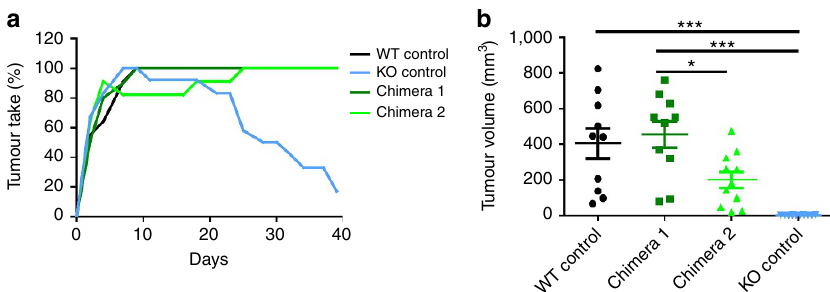
Figure 2 | Haematopoietic and non-haematopoietic stromal components are required for tumour rejection. BM chimeras (8–14 weeks old) were generated via irradiation of recipient mice and subsequent BM transfer from donor mice 1 day later. WT mice received BM from Tlr3/7/9 (cid:2) / (cid:2) mice to generate chimera 1 (dark green). To generate chimera 2 (light green), Tlr3/7/9 (cid:2) / (cid:2) mice received WT BM. As a control, irradiated WTmice received WT BM (black) and Tlr3/7/9 (cid:2) / (cid:2) mice received TLR-deficient BM (blue) ( n ¼ 10–12). Eight weeks later, MOPC cells were injected s.c. and tumour take (number of mice with palpable tumour) was recorded ( a ). Tumour volume 30 days after tumour injection of individual mice and mean (horizontal line) ± s.e.m. are shown; P -value (analysis of variance) is indicated ( b ). Results were considered significant at * P r 0.05 and *** P r